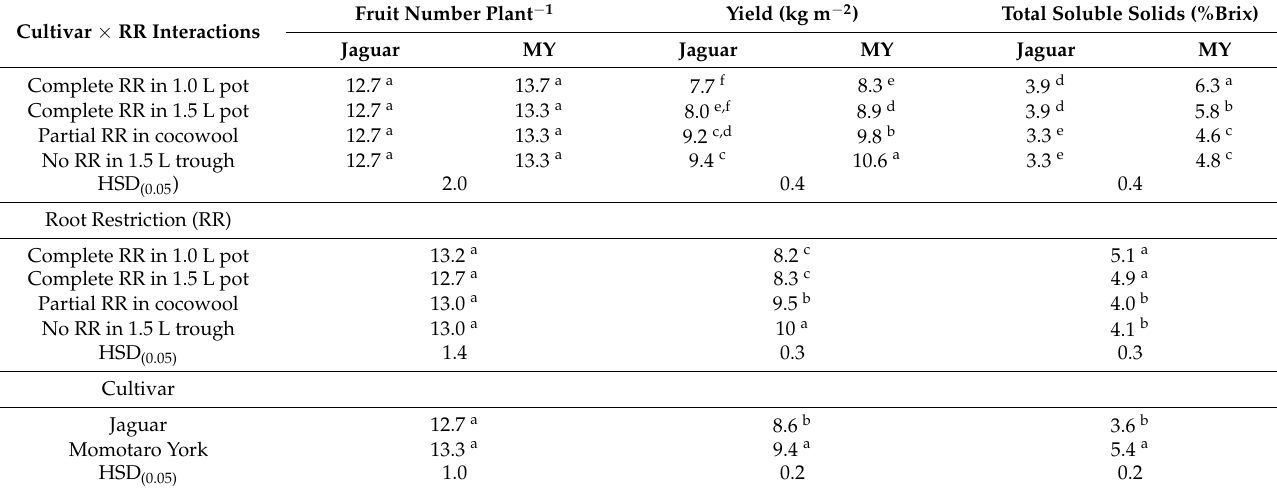
Table 3. Effect of root restriction (RR) on the yield and total soluble solids of tomato cultivars. Cultivar × RR